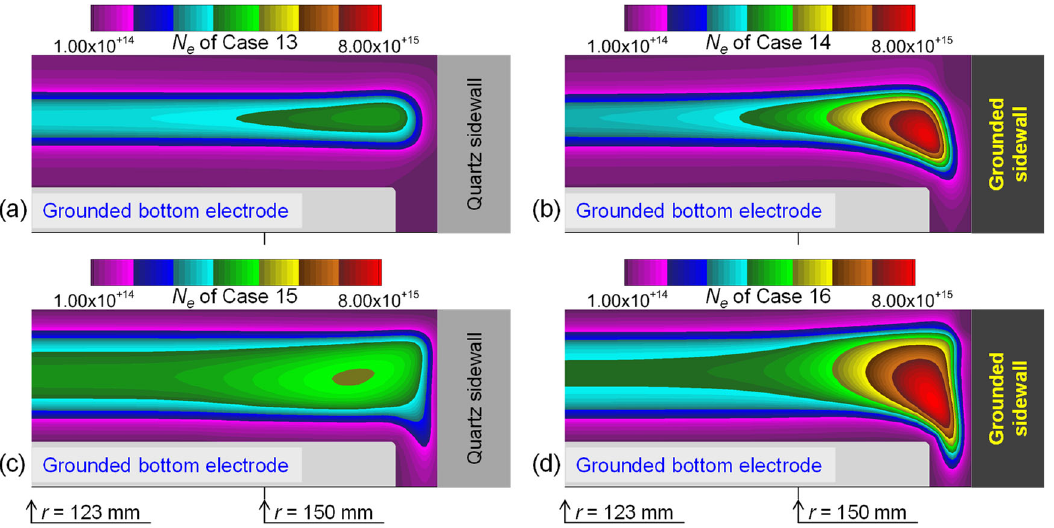
Figure 13. The spatial profiles of the time-averaged electron density ( N e , m − 3 ) ( a ) for Case 13, ( b ) for Case 14, ( c ) for Case 15, and ( d ) for Case 16.